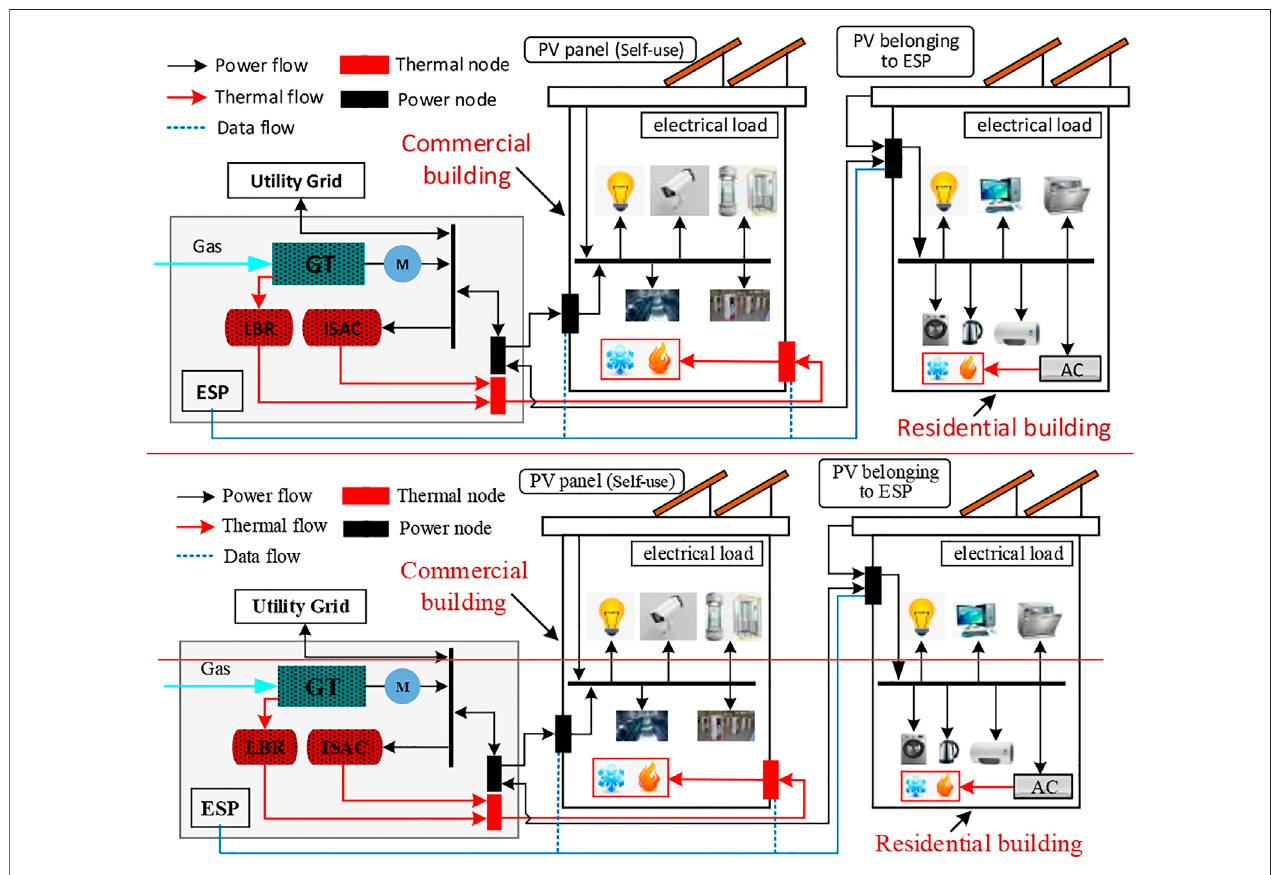
FIGURE 1 | Energy system structure of building cluster.